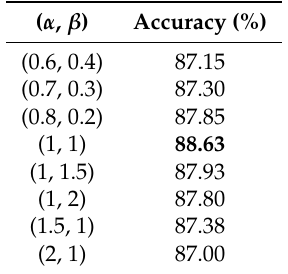
Table 5. The recognition accuracy (%) with different ( α , β )